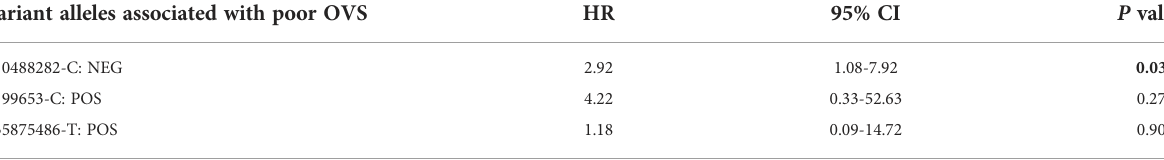
NEG, negative; POS, positive; HR, Hazard ratio; OVS, overall survival. Bold type indicates signi fi cant association level ( P <